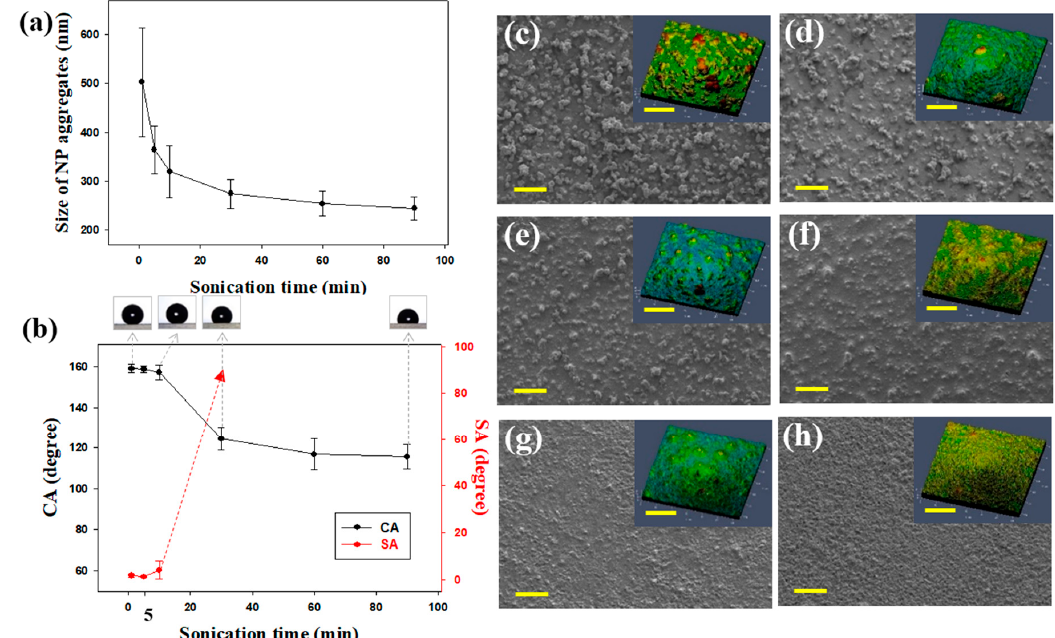
Figure 2. ( a ) Average sizes of silica NP aggregates measured by DLS after diluting the coating mixtures with ethanol. Measurements were performed after sonication for 1, 5, 10, 30, 60, and 90 min. ( b ) CAs and SAs of spray-coated samples with respect to sonication time. The red dotted line with an arrow indicates that SA measurement was not possible because a water droplet did not roll off at any angle. Static water droplets are shown above the corresponding sonication times. SEM and confocal laser scanning microscopy images of spray-deposited NPs on Si wafers after sonication for ( c ) 1, ( d ) 5, ( e ) 10, ( f ) 30, ( g ) 60, and ( h ) 90 min. Scale bar = 100 μ m.